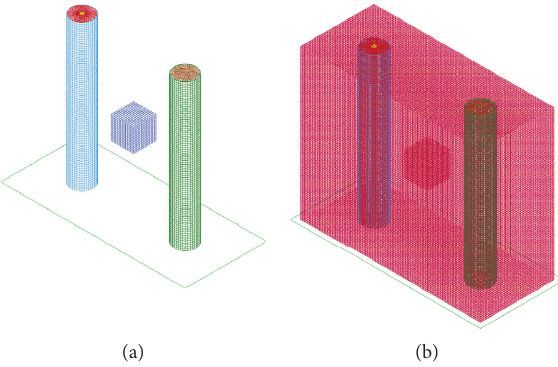
Figure 10: Finite element model. (a) Finite element model of columns and explosive. (b) Total finite element